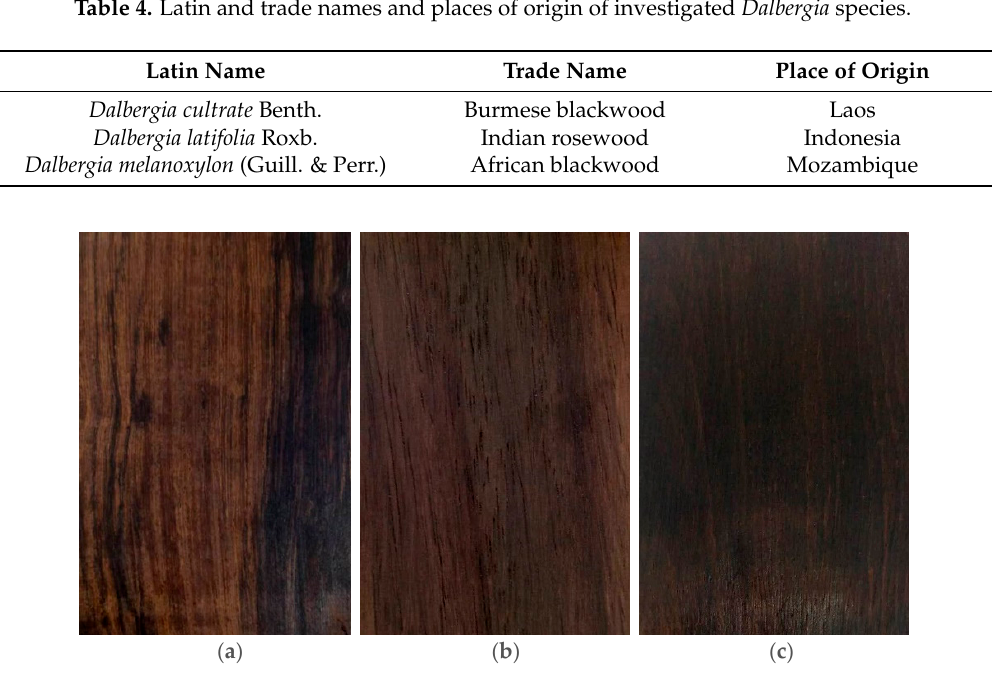
Figure 3. Heartwood of ( a ) Dalbergia cultrate, ( b ) Dalbergia latifolia and ( c ) Dalbergia